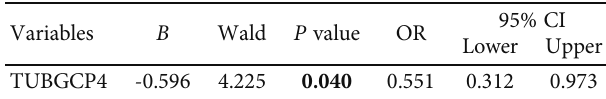
Figure 2: Association between TUBGCP4 expression and the prognosis of HCC patients. (a) Kaplan-Meier model was used to analyze the e ff ect of TUBGCP4 expression on the overall survival of HCC patients. (b) Kaplan-Meier model was used to analyze the e ff ect of TUBGCP4 expression on tumor-free survival of HCC patients. Table 3: COX regression analysis for overall survival of HCC patients after